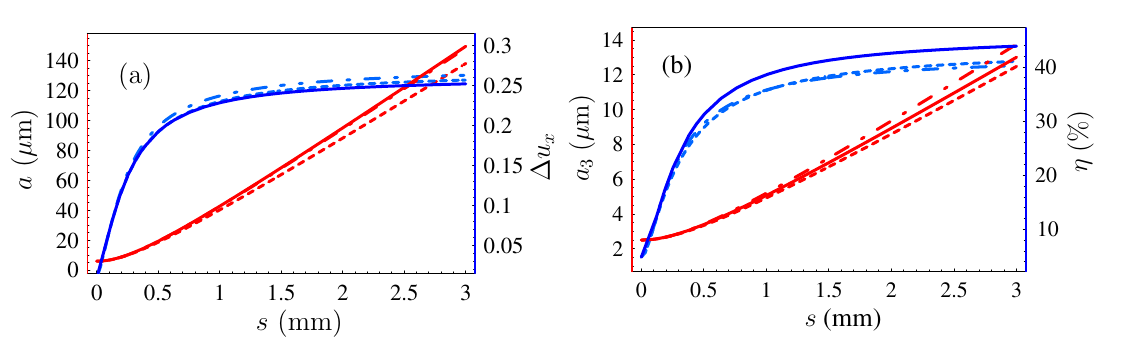
FIG. 6. (Color) Simulation of the space-charge blowup of a small energy spread compact electron bunch with input parameters: (cid:1) 5 : 25 MeV , radius a (cid:1) 6 (cid:4) m , half-length a Charge Q (cid:1) 100 pC , beam energy E 0 (cid:1) 2 mrad , typical distance between macroparticles n (cid:6) 1 = 3 gence x 0 p max (cid:10) transverse radius a (cid:1) (cid:1)(cid:1)(cid:1) 5 and transverse momentum spread (cid:1) u p x (cid:1)(cid:1)(cid:1) 5 i as a function of propagation distance s (cid:1) ct is shown using the envelope model (solid), 3D-PPI (dashed), and shell = h u (cid:1) u z z method